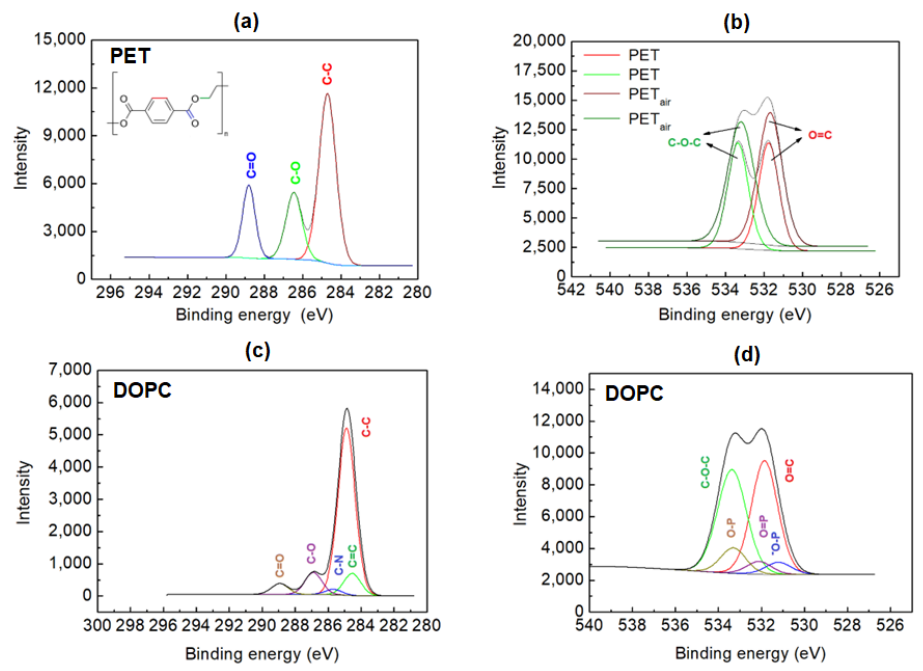
Figure 3. XSP spectra C 1s for unmodified PET ( a ), O 1s for unmodified and air plasma-activated PET ( b ), C 1s for PET air /AA/DOPC ( c ), and O 1s for PET air /AA/DOPC ( d ). Table 2. XPS data for unmodified and modified PET surfaces (conc. in at.%) .